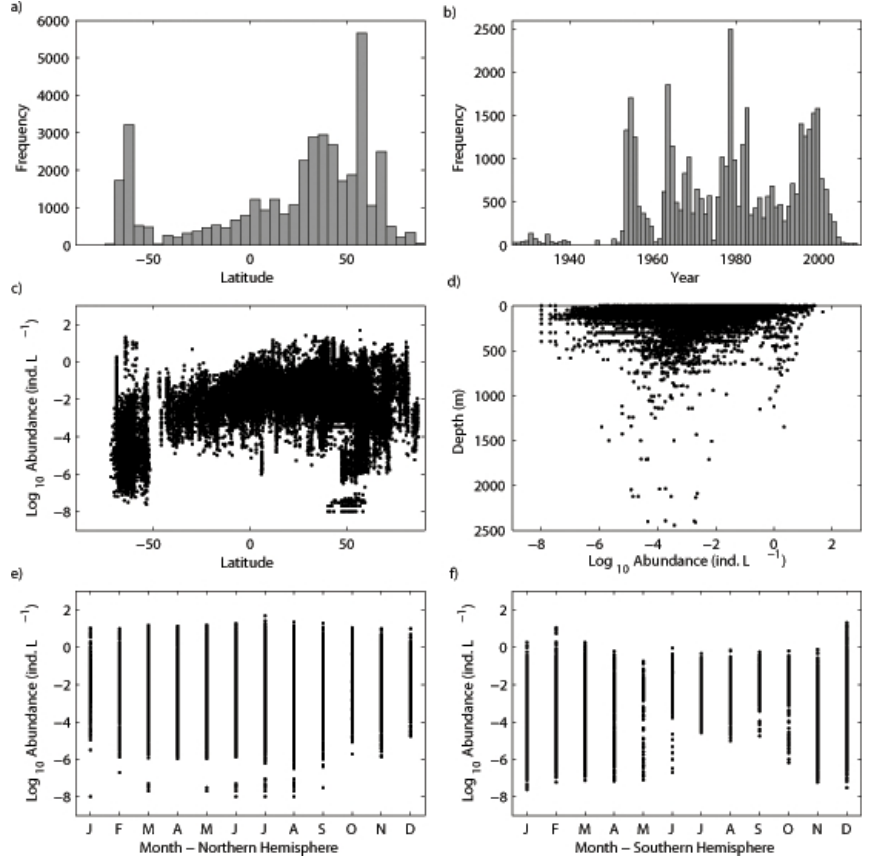
Figure 2. Description of macrozooplankton abundance: (a) latitudinal distribution of observations, (b) yearly distribution of observa- tions, (c) latitudinal distribution of abundance, (d) depth distribution of abundance, (e) monthly abundance distribution in the Northern and (f) Southern